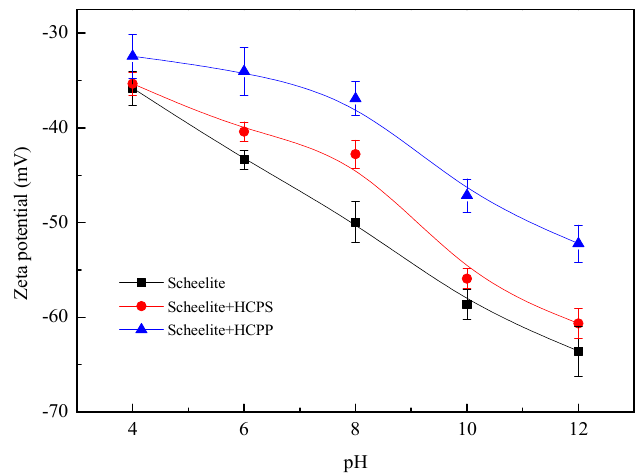
Figure 5. Zeta potentials of scheelite particles with different treatments (C(NaOl) = 2 × 10 −4 mol/L). Figure 6 indicates the interaction of particles and NBs through photo-micrographs. Generally, NBs generated by HCPS and HCPP are present in the mineral suspension in three states: free nuclei, adhering onto the surface of mineral particles, and forming bubble–particle aggregates. In the mineral suspension with HCPS, NBs are mainly free in the suspension, and particles are basically disperse. In contrast, in the mineral suspension with HCPP, most of NBs mainly adhere onto the surface of the are more likely to adhere onto the hydrophobized particles’ surface than BNBs, which is consistent with the data of zeta-potential measurements.